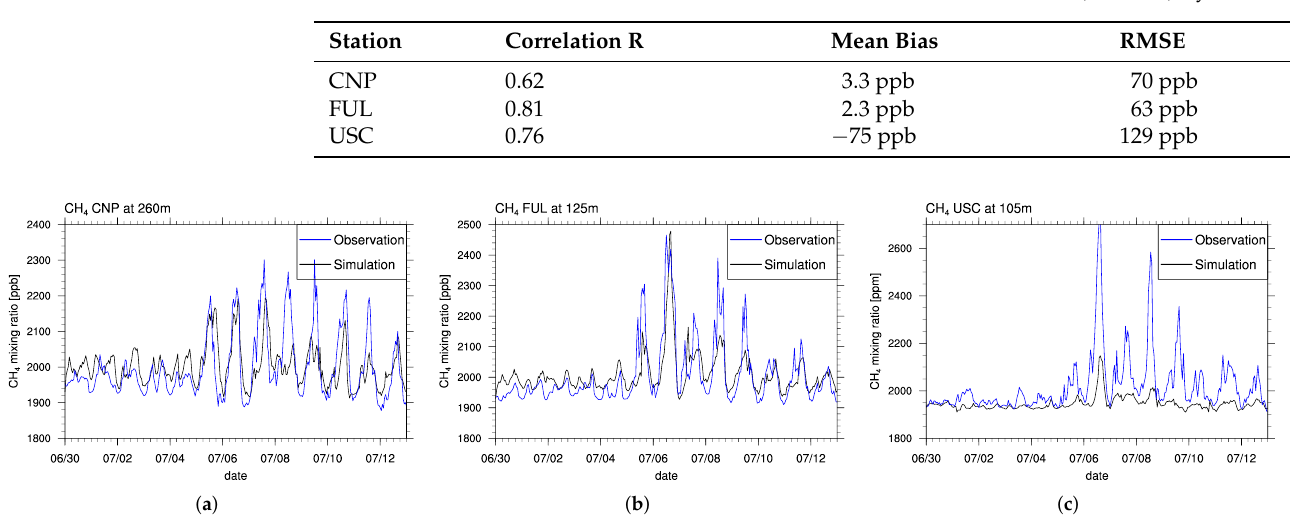
Figure 14. Modeled and observed CH 4 mixing ratio at Canoga Park ( a ), Fullerton ( b ), and University of South California ( c ) in Los Angeles, in early July